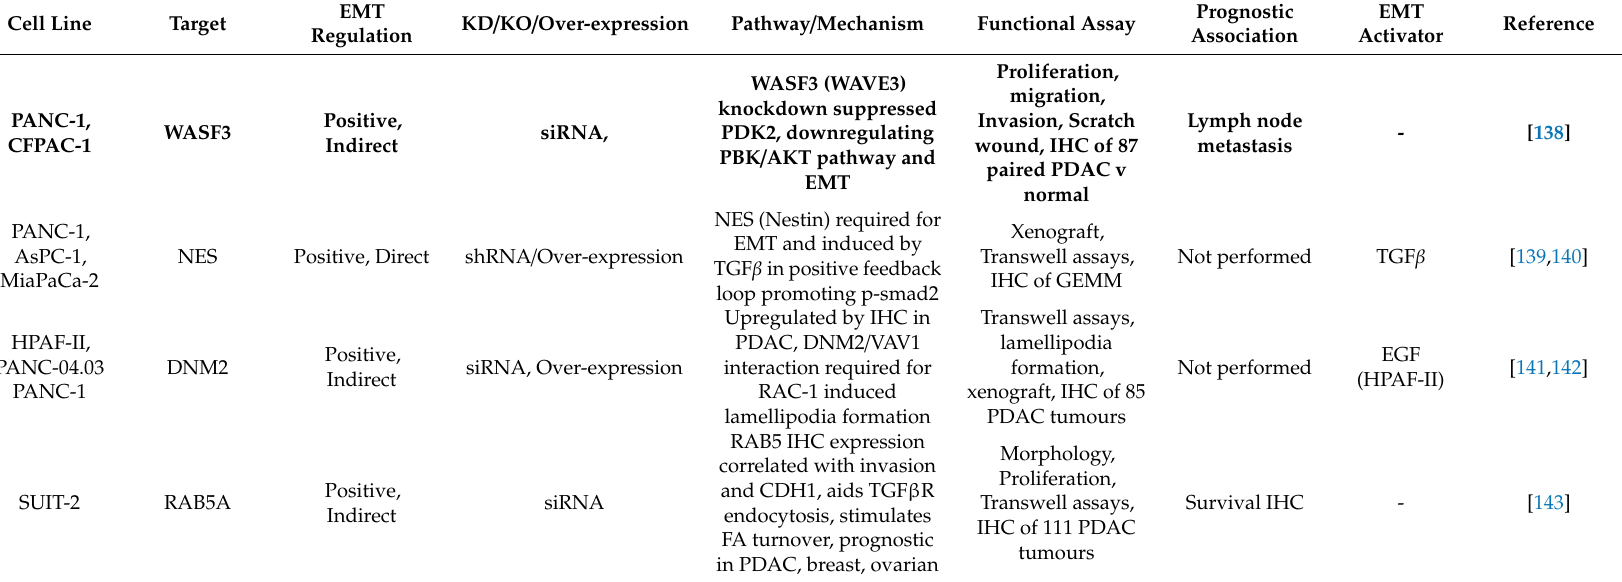
Table 4. Cytoskeletal adaptors. This table describes intracellular adapter proteins that may participate in and be required protein complex localization and transduction of signals that modulate EMP. Candidates that exhibit clinical correlation with lymph node metastasis are shown in